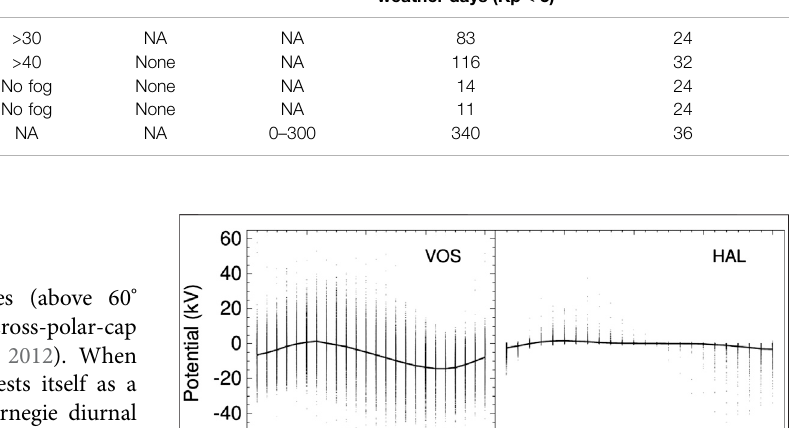
TABLE2| Summaryofcriteriausedtode fi nefairweatherconditionsateachofthehighlatitudesites,andthetotalnumberofdaysonwhichfairweatherwasdetected.Days on which the geomagnetic Kp index was ≥ 5 were excluded. Location